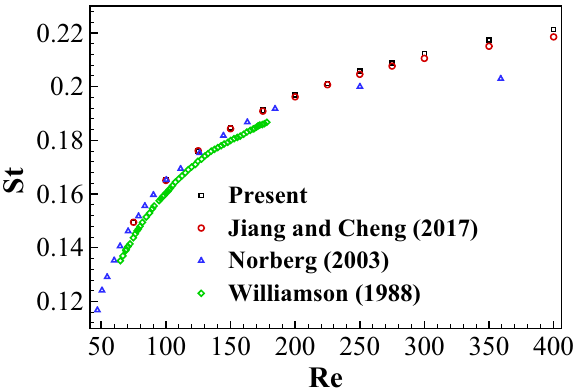
Figure 3. Strouhal number as a function of the Reynolds number for a uniform flow over a stationary